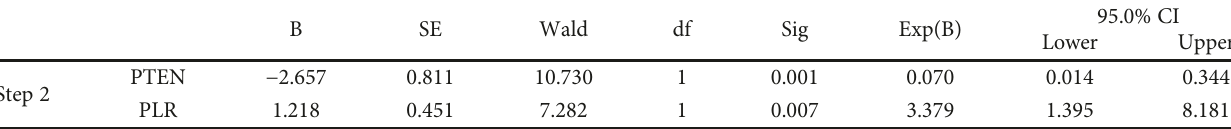
Figure 2: Univariate analyses of overall survival according to PTEN, PLR, and NLR at the time of diagnosis. Table 5: COX analyses of prognostic factors with overall survival of